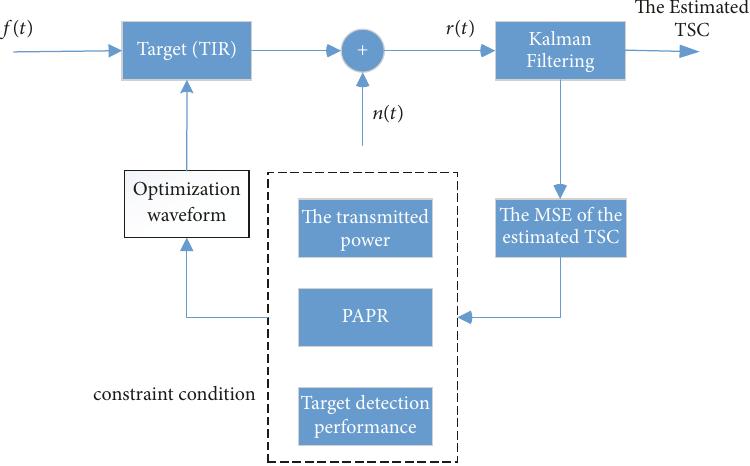
Figure 1: The system model of the temporal correlated cognitive